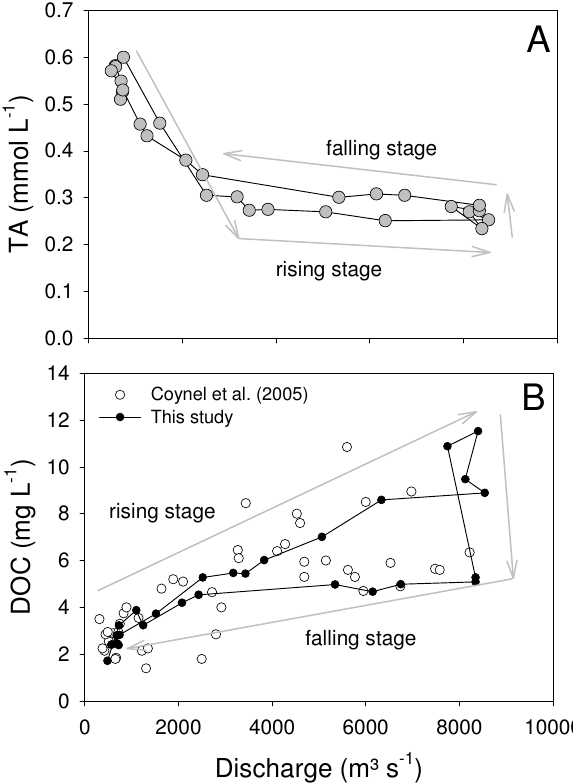
Fig. 9. Seasonal variations of (A) total alkalinity, and (B) dis- solved organic carbon concentrations, showing different hysteresis patterns. DOC data from this study are compared with data from Coynel et al. (2005).